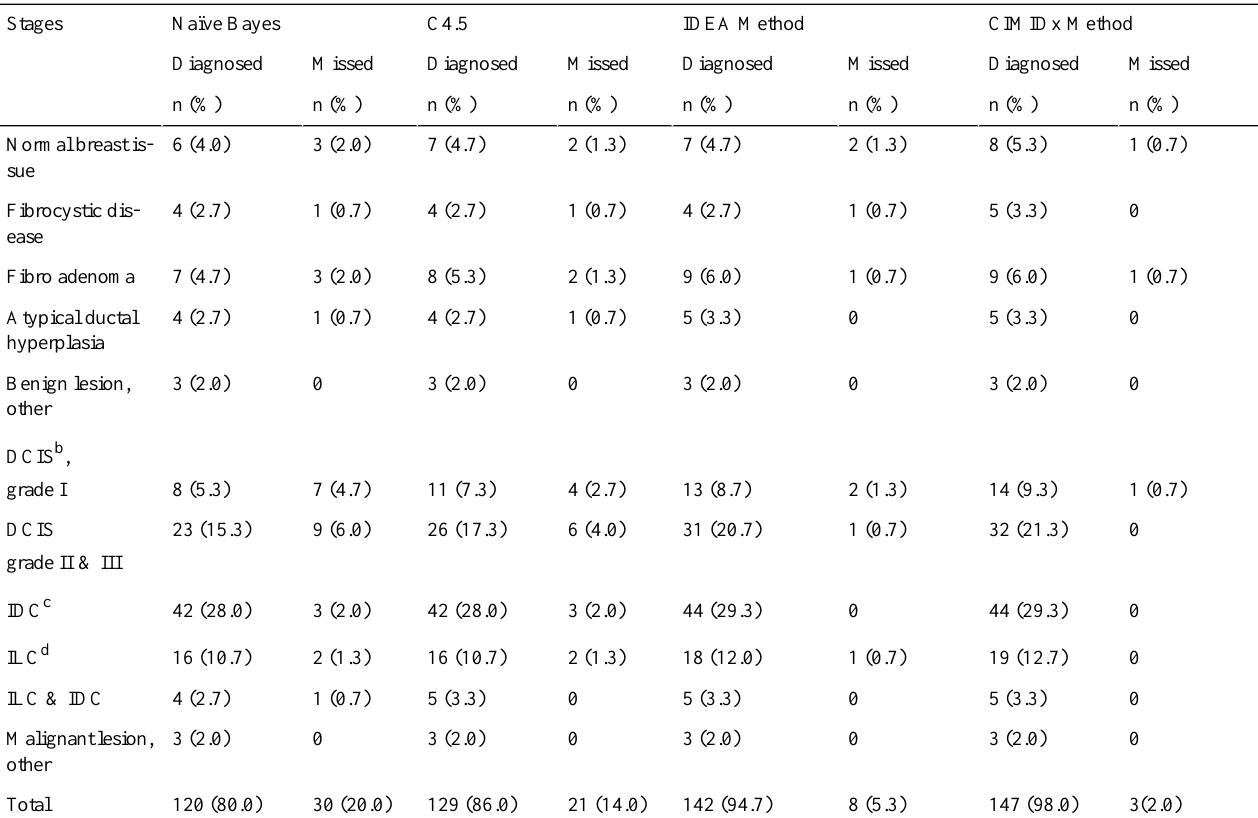
Table 2. The classification accuracy of the proposed CIMIDx cloud services model with 150 client test images during the development of CIMIDx, and compared with the Naïve Bayes and C4.5 classification algorithms and IDEA method (n=150).